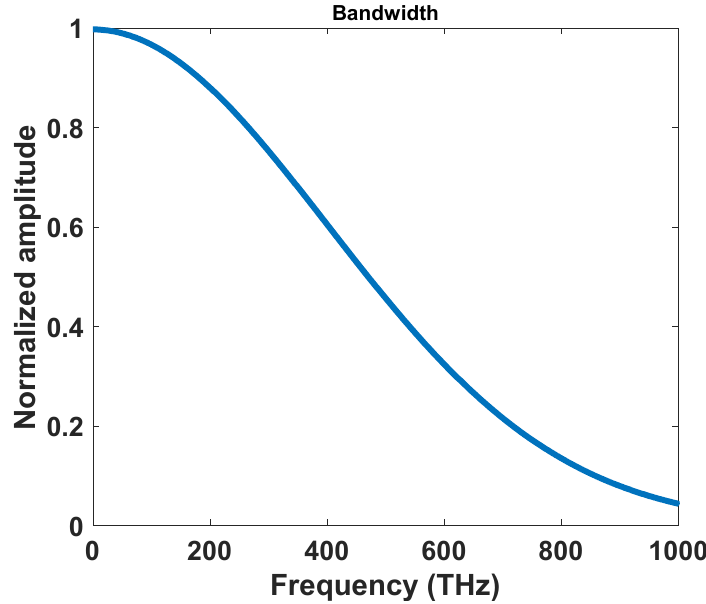
Figure 10. The total number of photons in the output port of the proposed device versus modulation frequency (total number of photons = summation on photons in the output band).